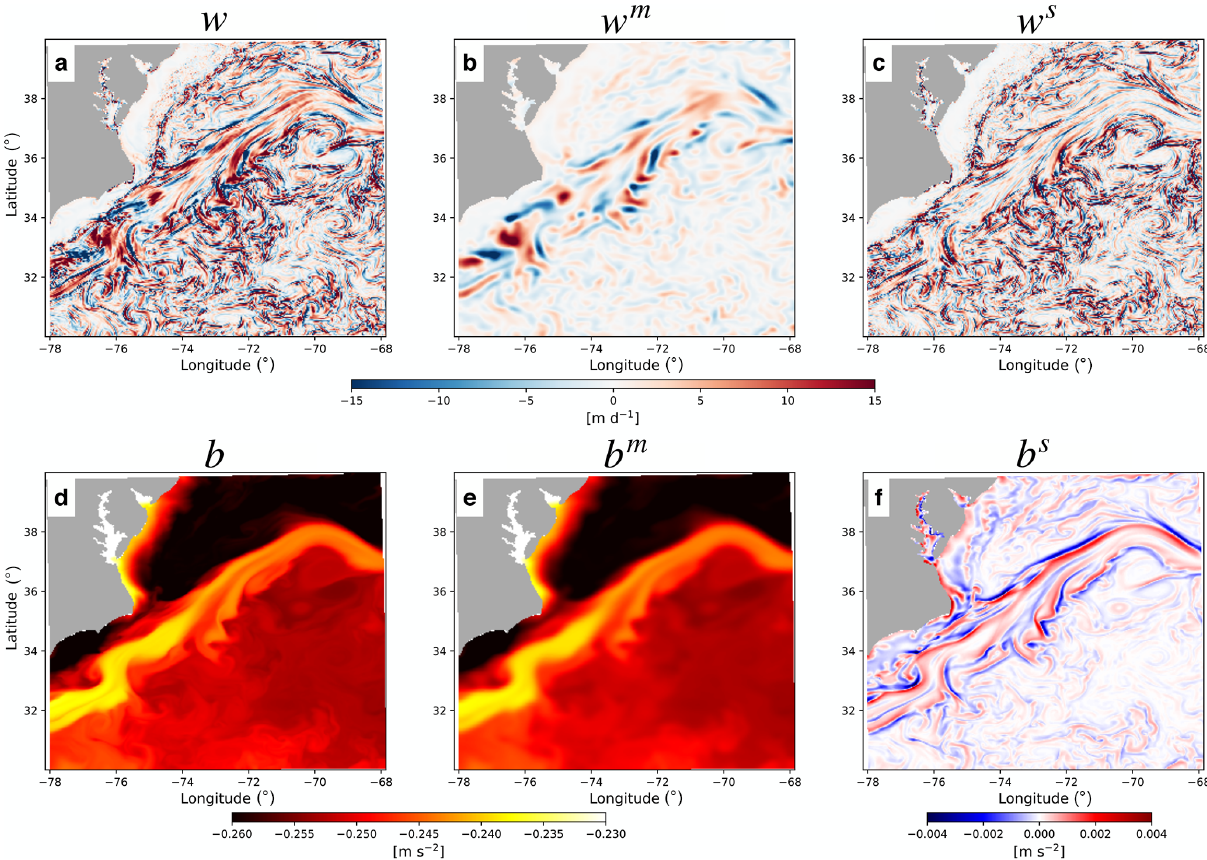
Figure 5. Snapshot from eNATL60 on 1 February 2010 at depth 18m of the unfiltered daily w and b (a, d) , filtered fields applying the Gaussian filter ( w m ,b m ; b, e ), and the residual ( w s ,b s ; c, f ).